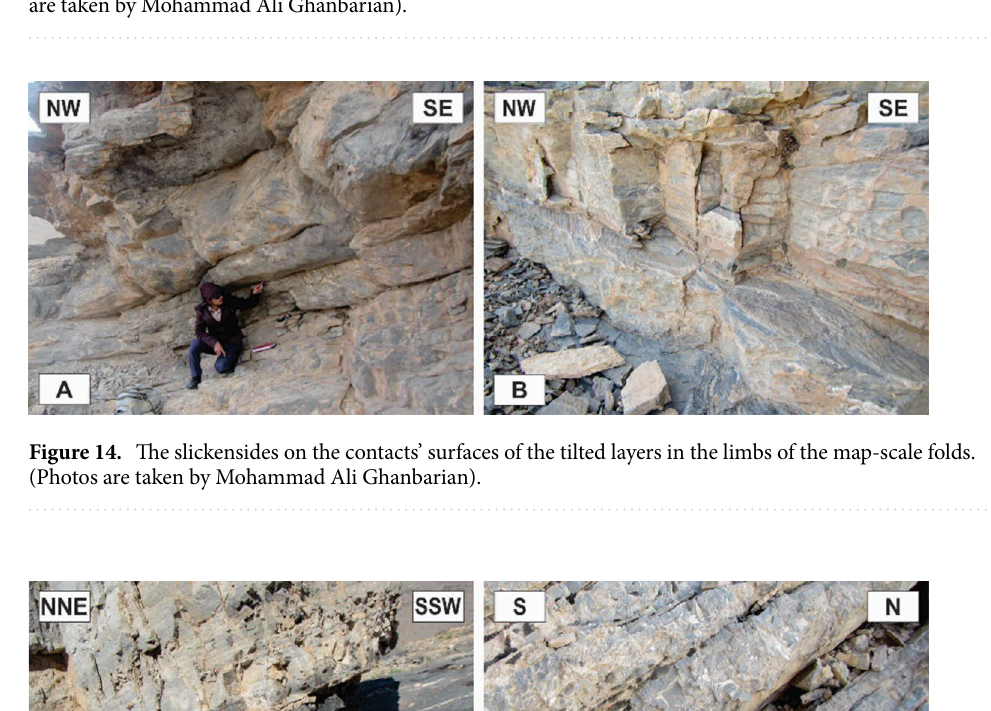
Figure 13. Annotated field photograph of the outcrop-scale strike-slip ( A , B ) and normal ( C , D ) faults. (Photos are taken by Mohammad Ali Ghanbarian).